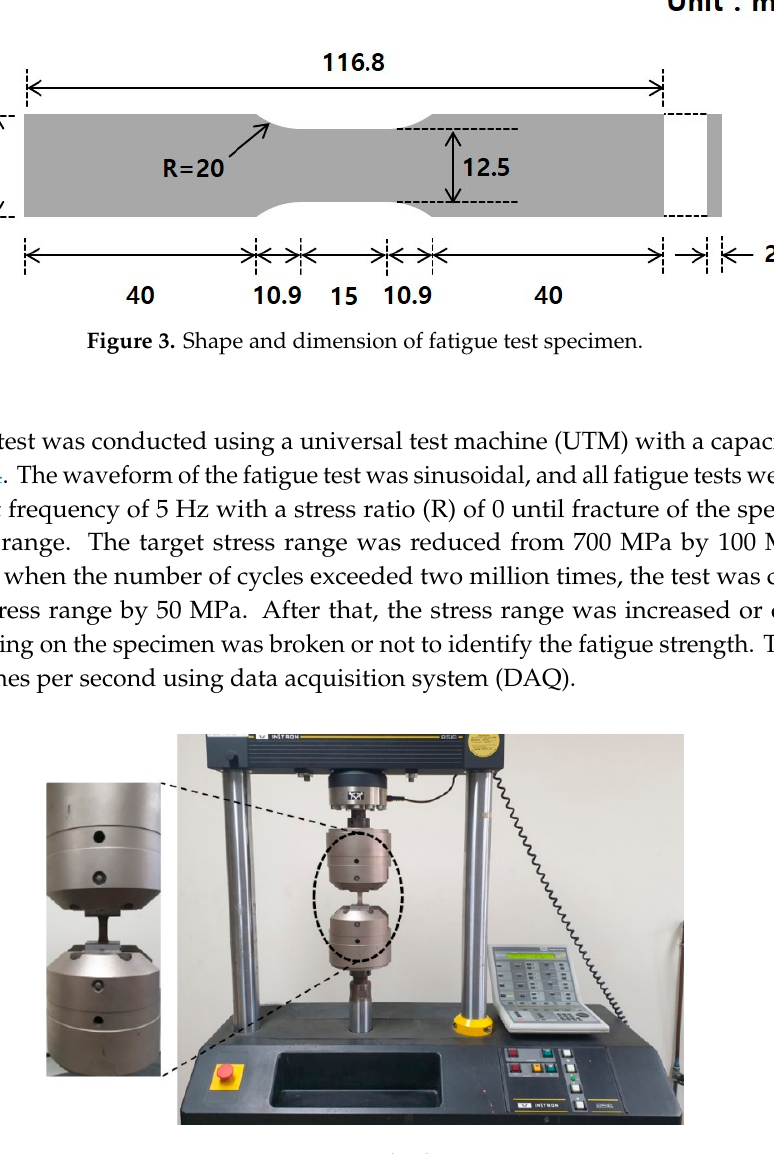
Figure 2. Recovery stress–temperature curves according to type of Fe-SMA at prestrain 0.04, heating temperature 160 ℃ [12].